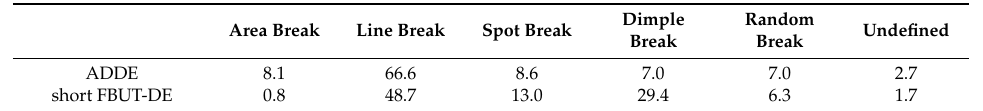
Table 3. Tear breakup patterns of aqueous deficient dry eye and short fluorescein breakup time dry eye subgroups.